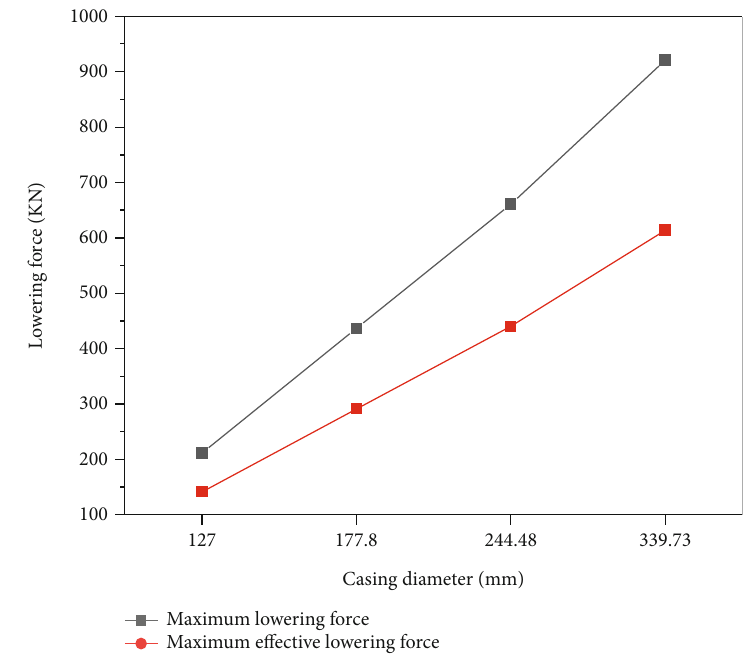
Figure 13: Lowering force on the casing string for di ff erent casing diameters.